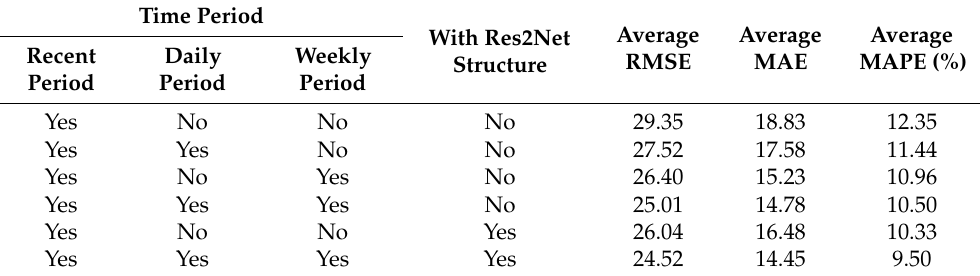
Table 5. Influence of different time periods on prediction (with PeMS08 as an example). Time